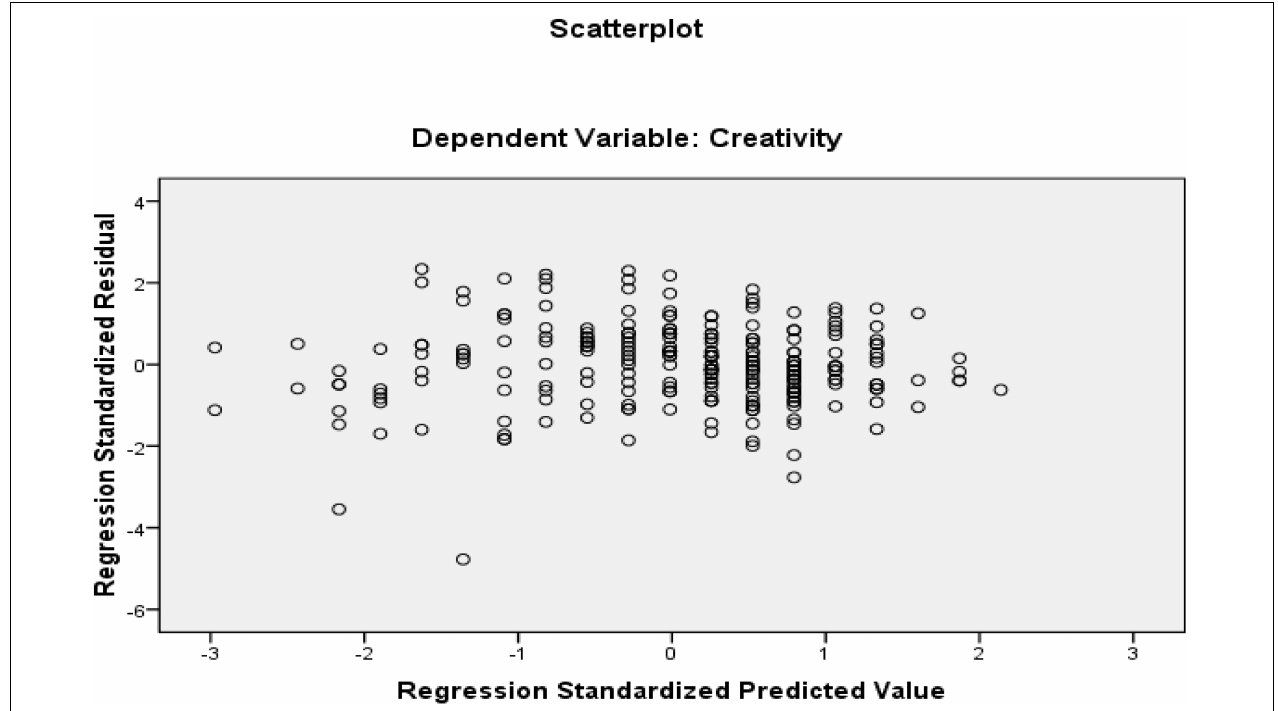
FIGURE 7 | Scatter plot of residuals (independent variable = grit and dependent variable = creativity).